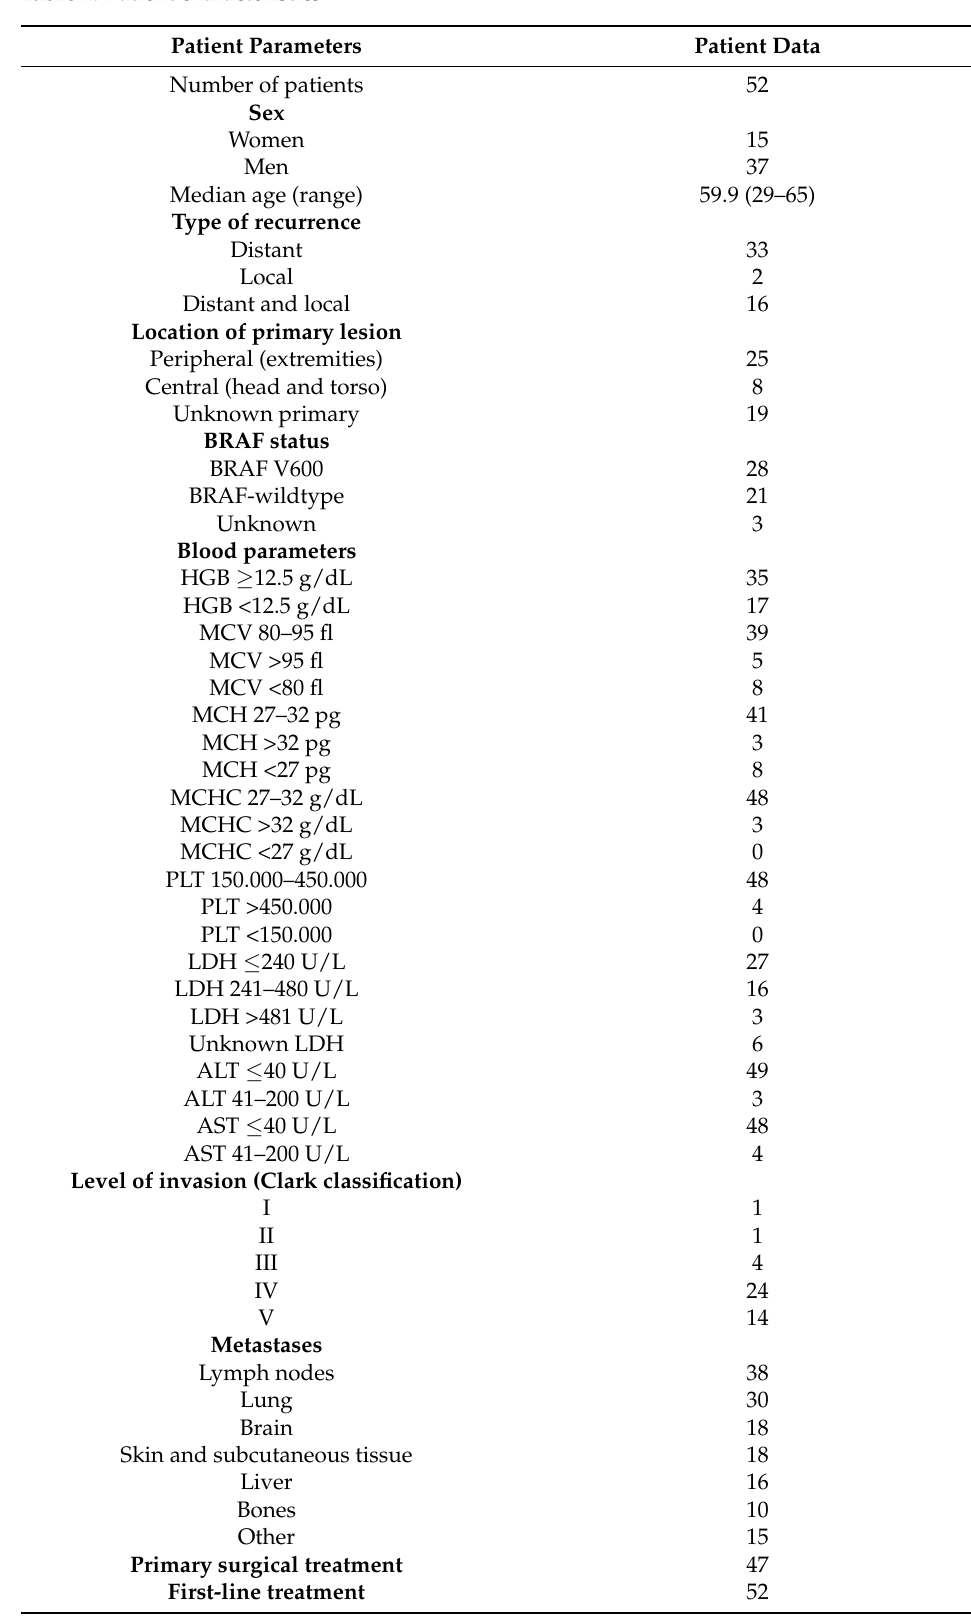
Table 1. Patient